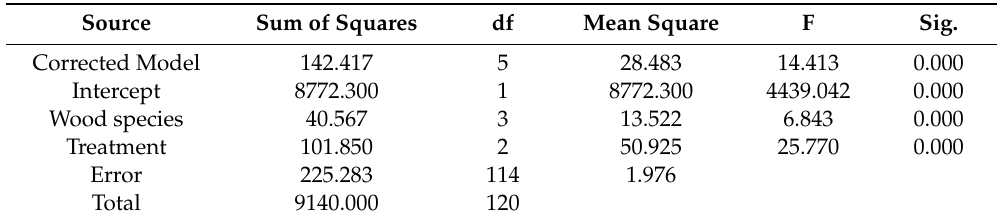
Table 7. Variance analysis of protection level.